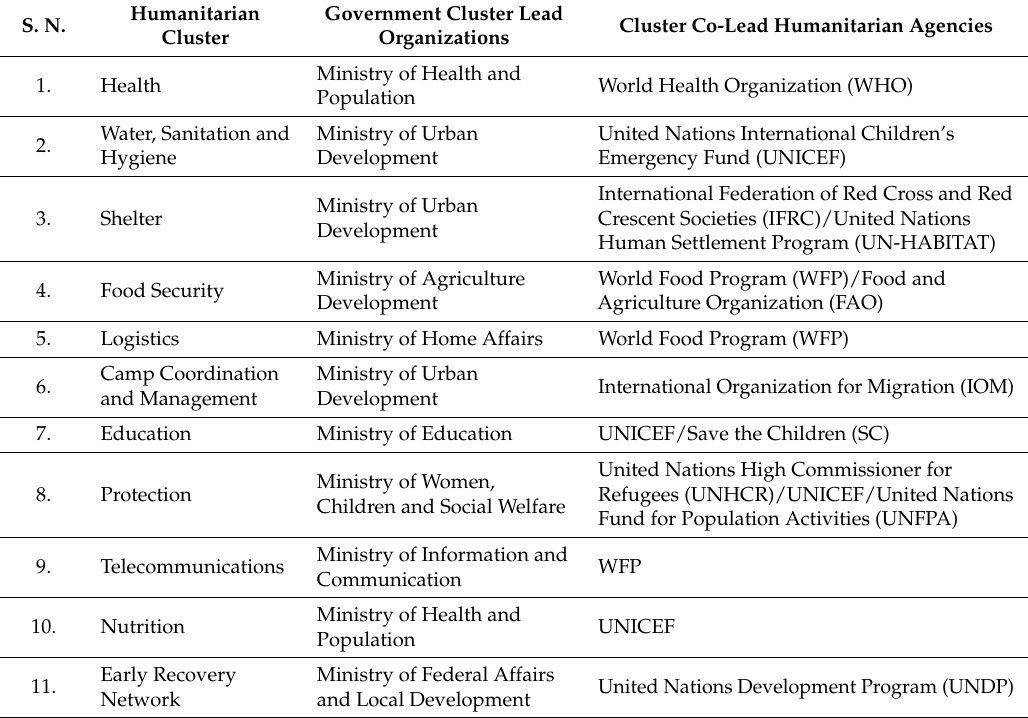
Cluster coordination structure involving government and non-government humanitarian